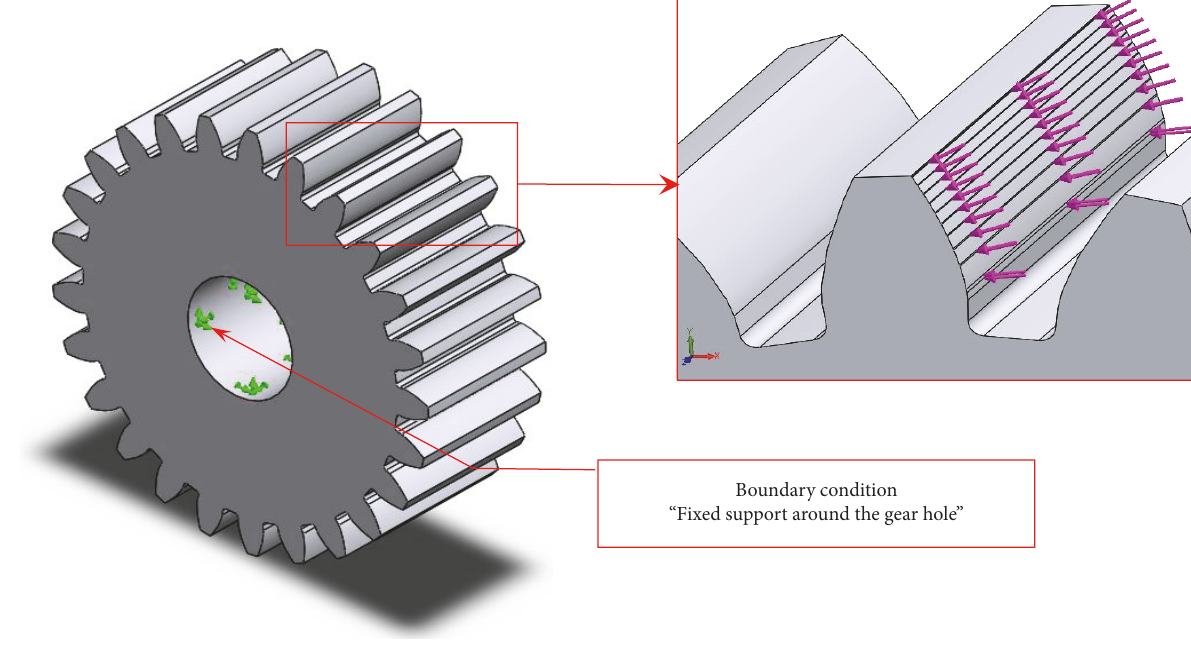
Figure 9: Different locations of the force along the tooth surface [17].